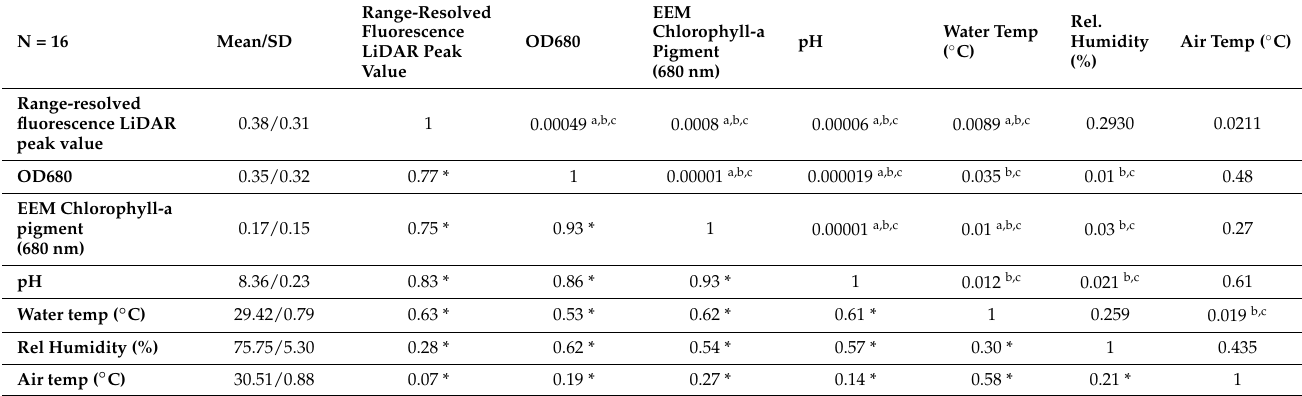
Table 3. Statistical summary of all data collected from the C. reinhardtii